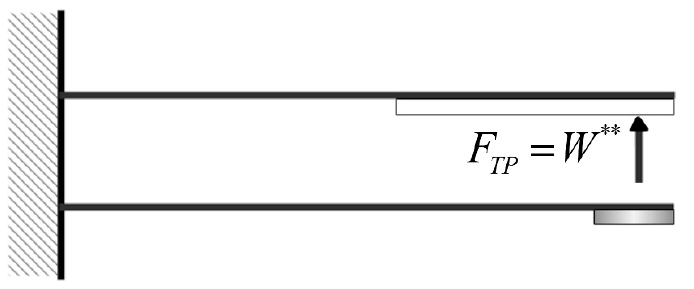
( c ) Figure 8. SES system theoretical voltage output (dimensionless). ( a ) 1st mode, ( b ) 2nd mode, and ( c ) 3rd mode.